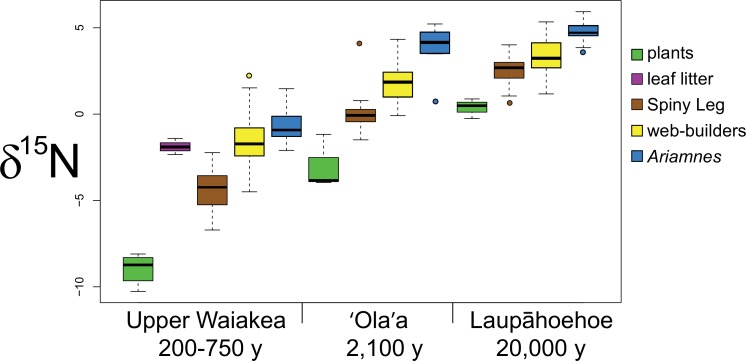
Boxplots showing nitrogen isotope ratios of functional groups across sites.Nitrogen isotope ratio (δ15N in ‰  units) of plant leaves (green), leaf litter (purple), Spiny Leg (brown), web-building (yellow) and Ariamnes (blue) spiders across sites of different ages.